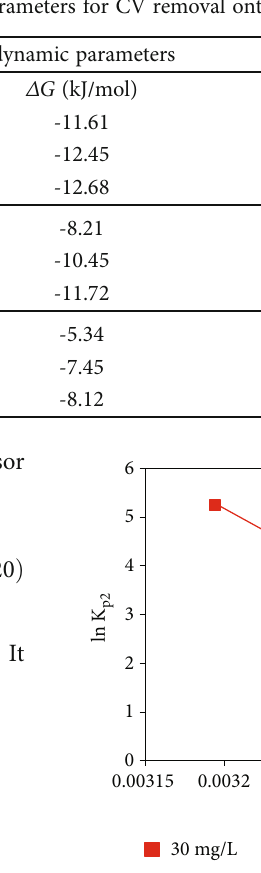
T ( pH = 6 : 0 , CVdose = 0 : 15 p 2 vs. 1/